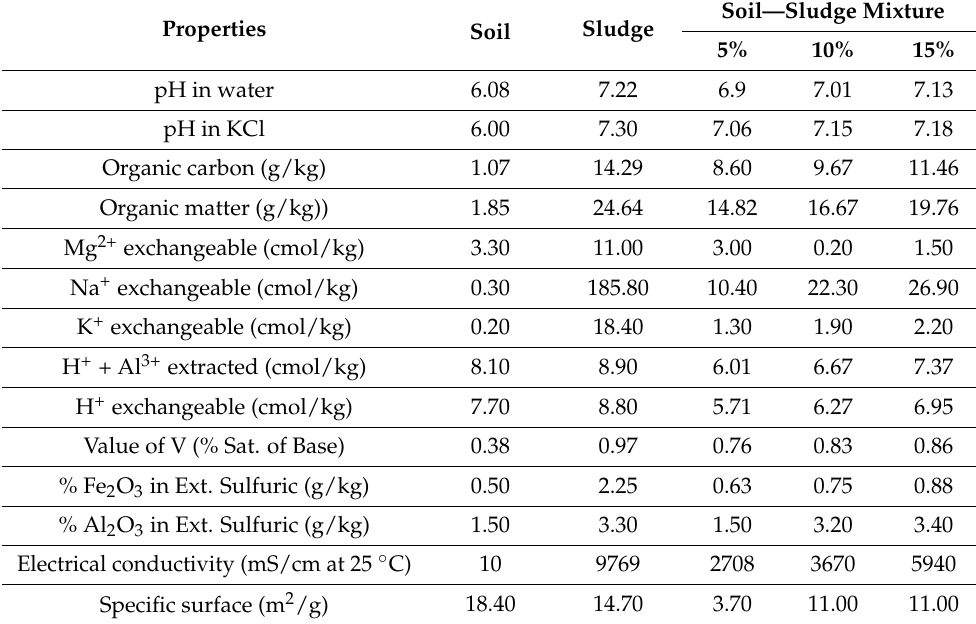
Table 3. Chemical characterization of soil, sludge, and soil–sludge mixture.